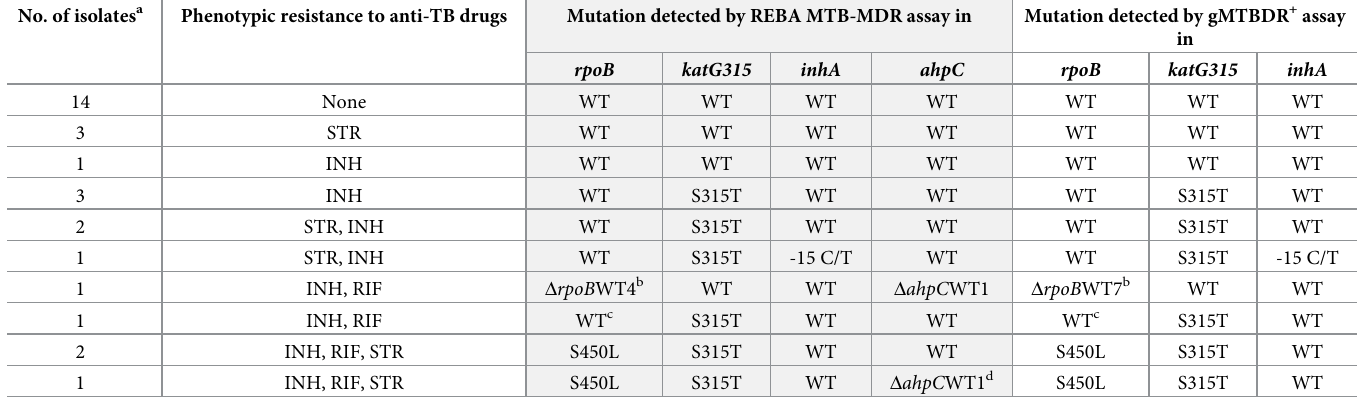
Table 1. Phenotypic and genotypic drug susceptibility testing of M . tuberculosis isolates by MGIT 960 system, MolecuTech REBA MTB-MDR and GenoType MTBDR plus